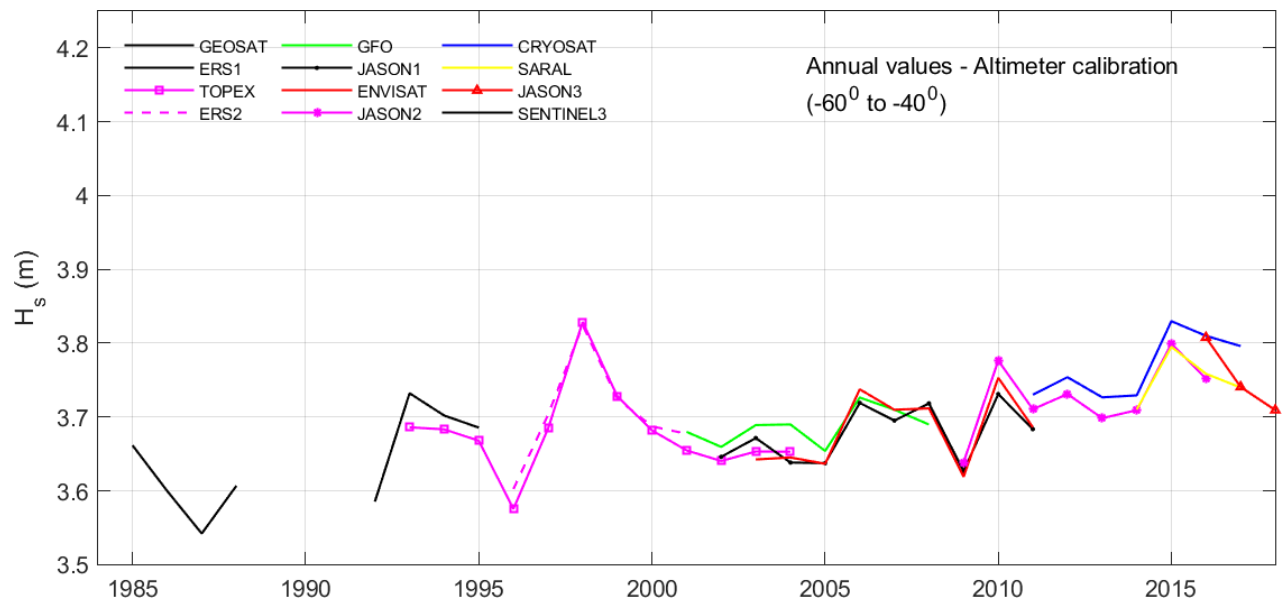
H as a function of time, as in Figure 6c, but averaged s H axis is the s